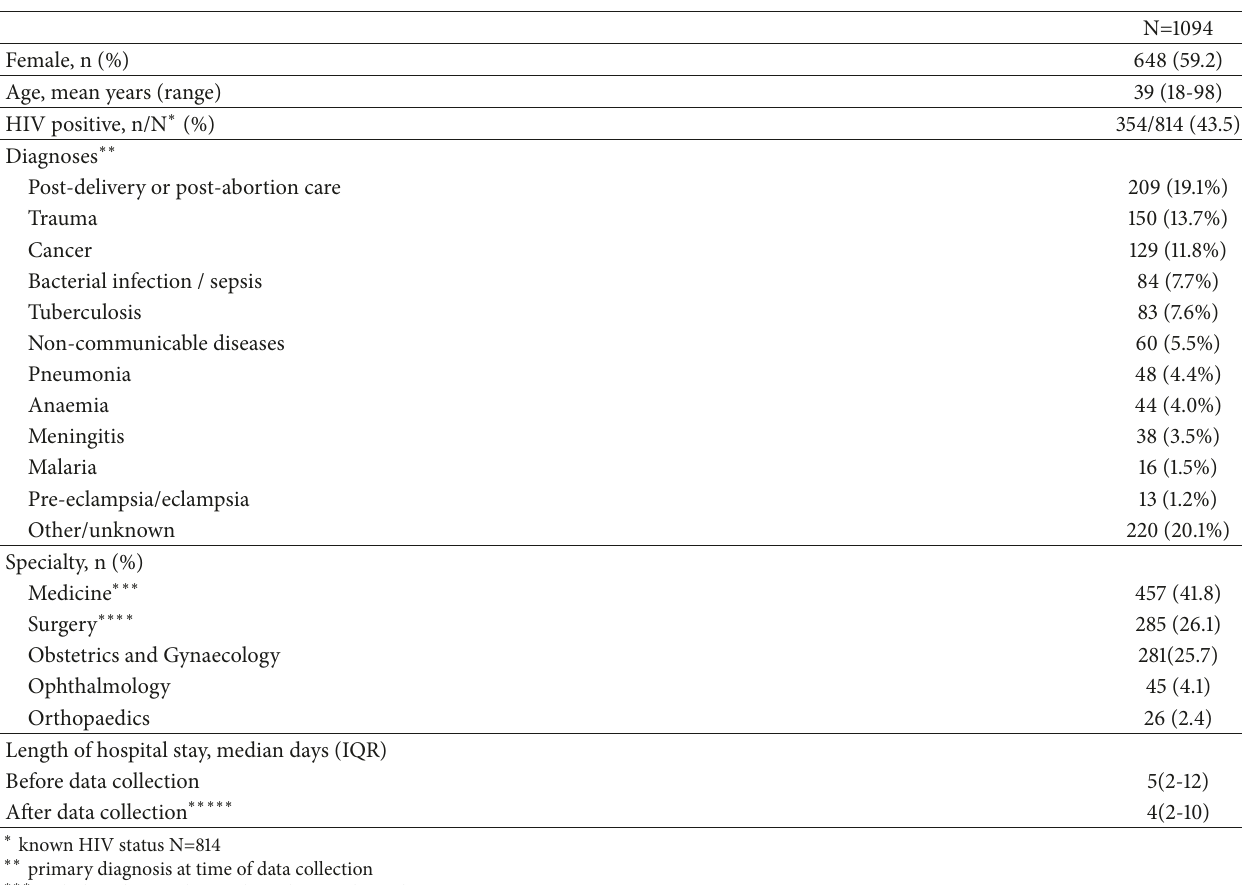
Table 1: Patient characteristics.